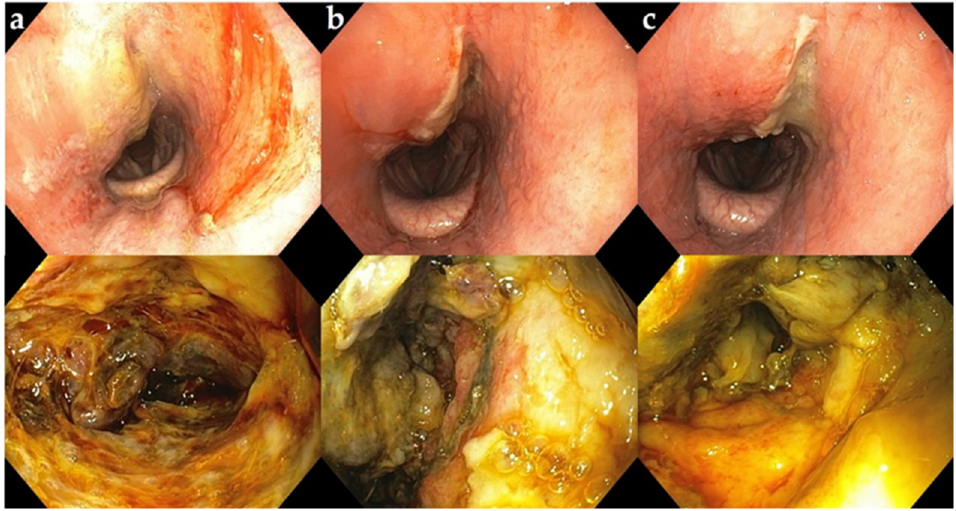
Figure 5. Endoscopic view of the upper respiratory area (upper row) and interior of the abscess (lower row) postoperatively after washing the cavity with povidone–iodine. ( a ) Day 1 after surgery; ( b ) day 2 after surgery; ( c ) day 3 after surgery. ( b ) day 2 after surgery; ( c ) day 3 after